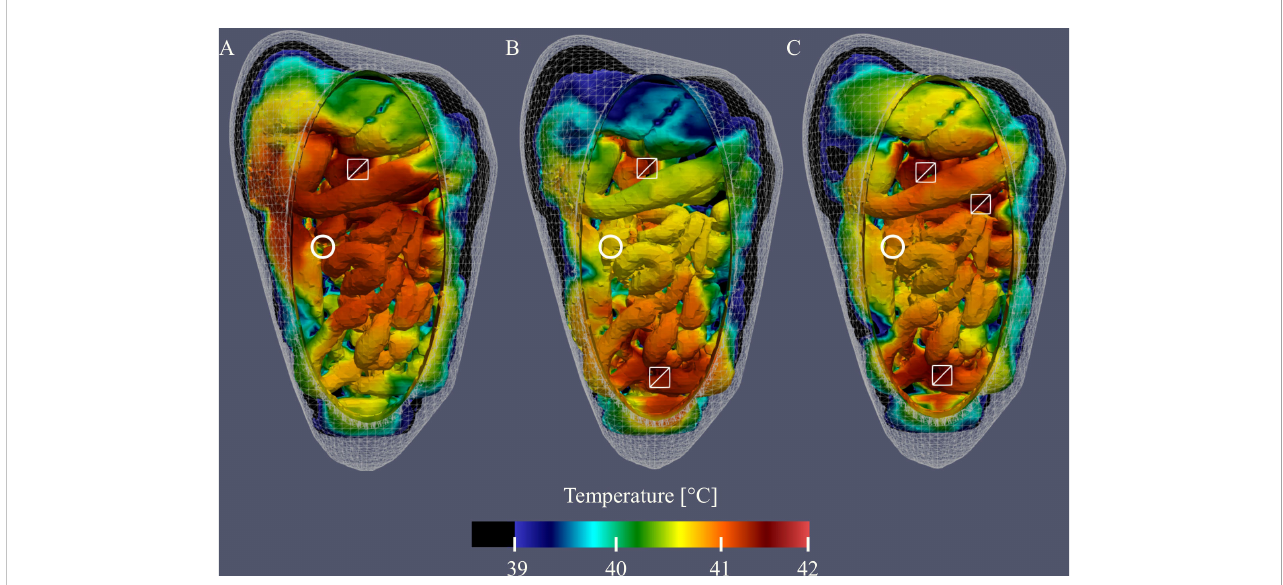
FIGURE 9 Visualization of the simulated thermal distributions and the effect of changes in catheter setup on the distribution. White squares denote the location of the in fl ow catheter, white circles denote the location of the out fl ow catheter and temperatures below 39°C are black. The thermal distribution of case #1 (A) shows that using one in fl ow at high fl ow rate results in high temperatures near the in fl ow and surroundings. Addition of 1 (B) or 2 (C) extra in fl ow catheters results in a more homogeneous overall distribution.